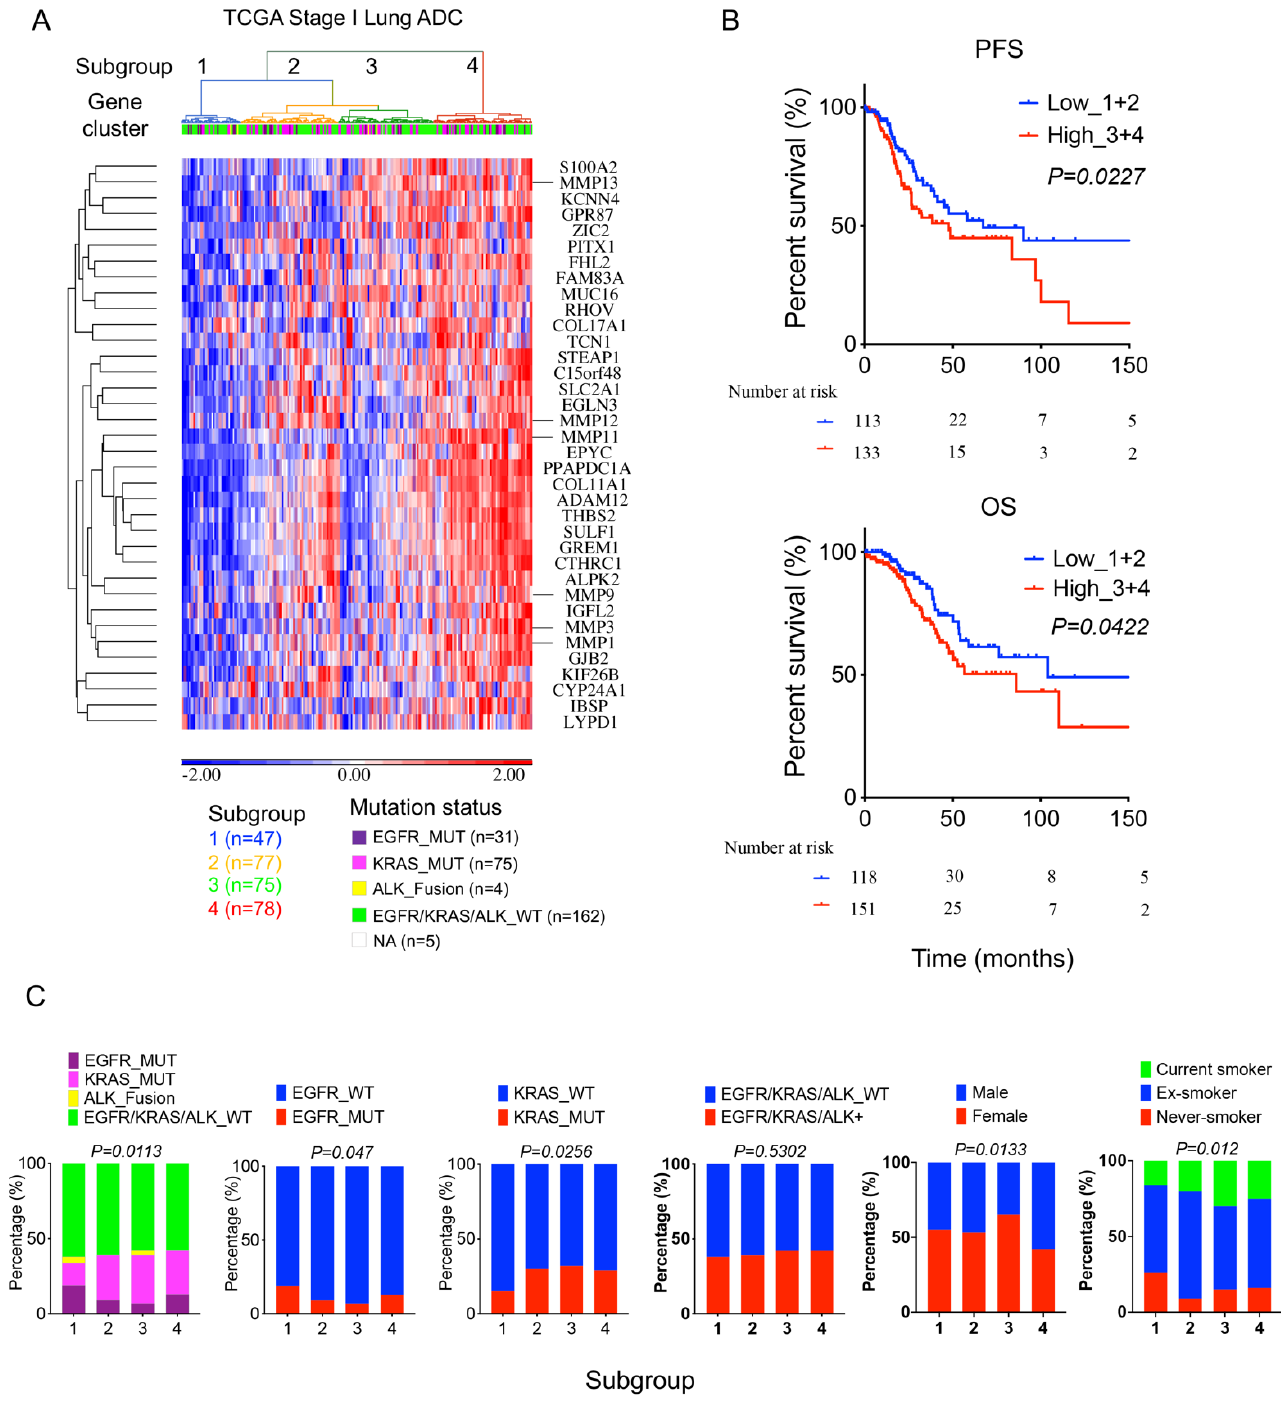
Figure 5. High MMP gene signature expression predicts poor survival outcomes in stage I lung adenocarcinoma from the TCGA cohort; 277 stage I lung adenocarcinoma patient samples from the TCGA cohort were analyzed: ( A ) An unsupervised hierarchical clustering heatmap revealed four lung adenocarcinoma subgroups clustered with 36-gene MMP signature. ( B ) Kaplan–Meier survival analysis of patient subgroups based on the 36-gene MMP signature performed using the log-rank test. ( C ) The distribution difference among the four subgroups stratified by gene mutation, gender, and smoking status was tested by the Chi-squared test. 2.6. A 36-Gene MMPs Signature Is Validated in An Independent Lung Cancer Cohort